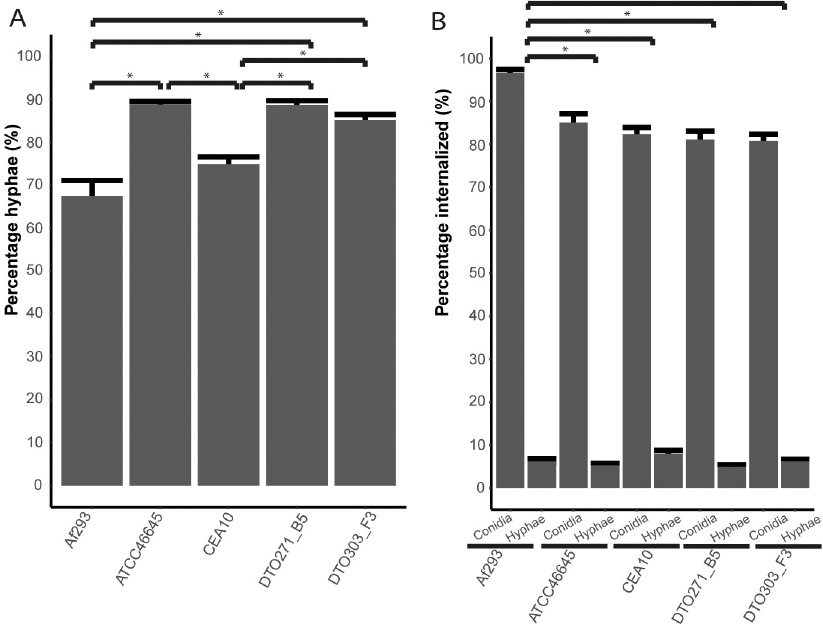
Fig 4. Germination of A . fumigatus during coincubation with epithelial cells. Percentage of hyphae after 12 h of incubation with type II A549 lung epithelial cells (A). Internalized conidia or hyphae after 12 hours of incubation with the A549 lung epithelial cells (B). Bars represent the average ( ± SE) of three independent experiments. � indicates statistical significance, based on a Kurskal Wallis test with a p-value � 0.05.